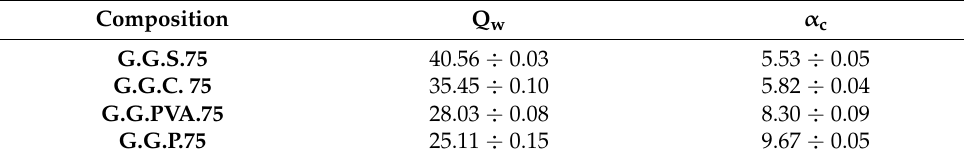
Table 8. The equilibrium swelling Q w and the degree of cross-linking α c